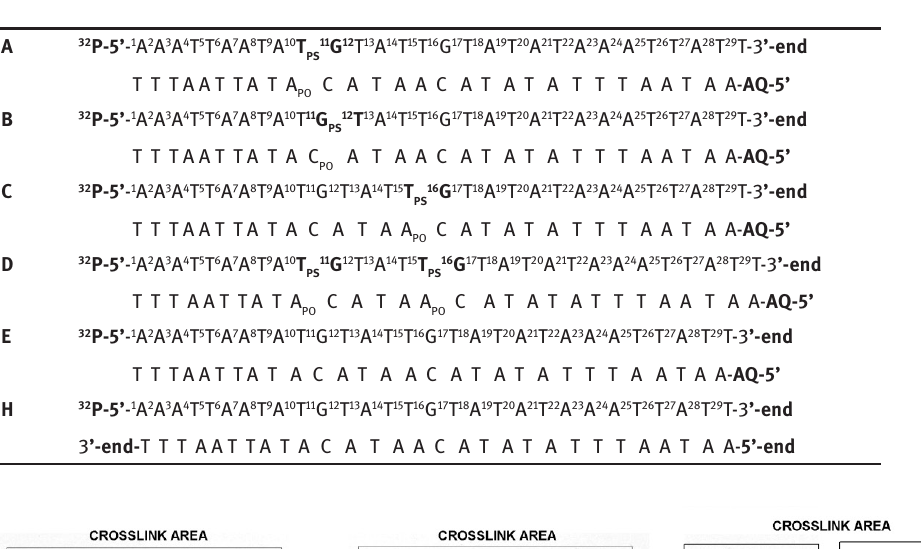
Table 1: Structure of ds -oligonucleotides indicating the position of the phosphorotioate internuclotide bond.